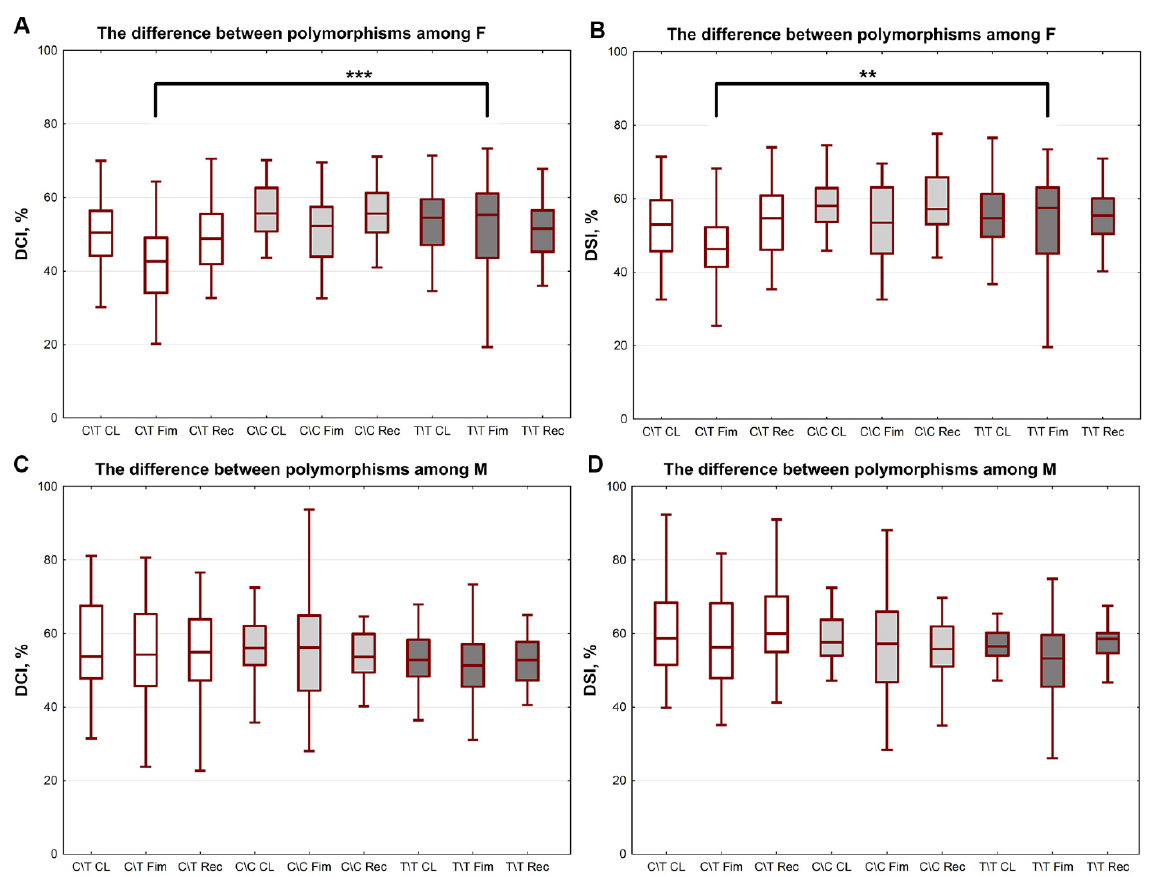
Figure 3. Dynamic of pulmonary blood flow in women with different ADRA1A gene polymorphisms. ( A ) Dicrotic index (DCI) and ( B ) diastolic index (DSI) in women with C/T, C/C, and T/T allele variants during imitation of diving reflex. ( C ) DCI and ( D ) DSI in men with C/T, C/C, and T/T allele variants during imitation of diving reflex. CL — control level, FIm — face immersion, Rec — recovery after face submersion. ** — p < 0.01; *** — p < 0.001; n = 50.